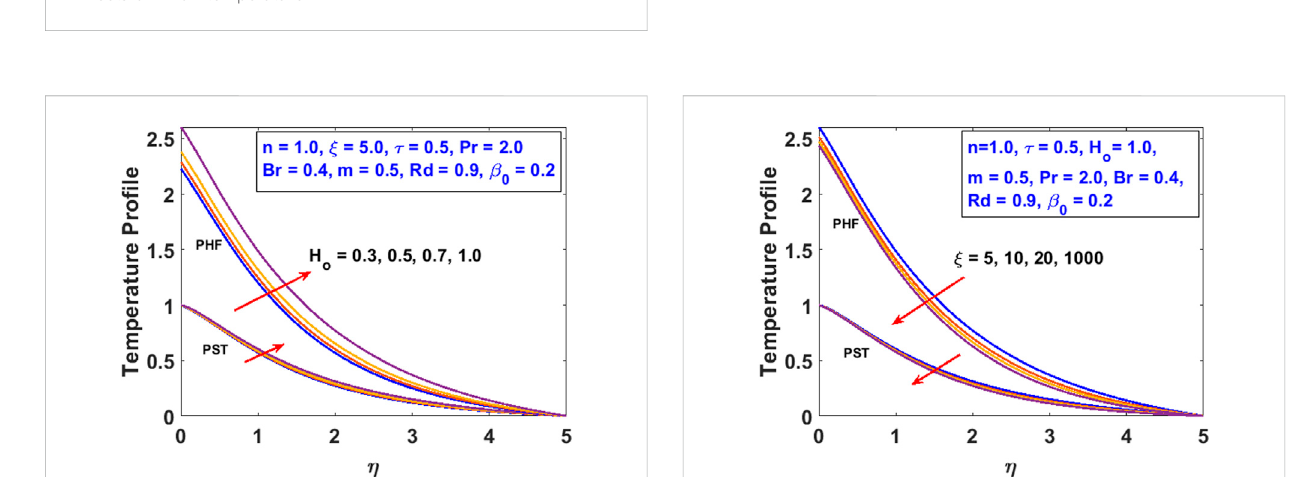
FIGURE 13 Effects of Br on temperature.